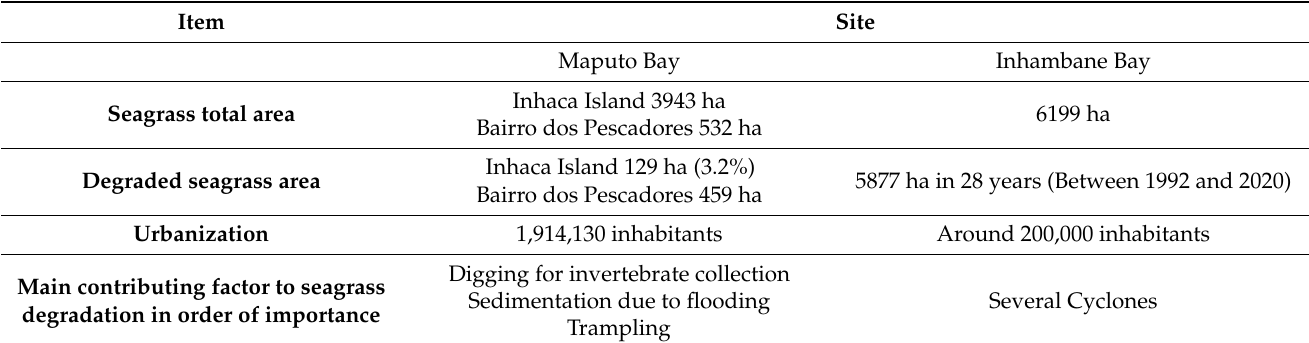
Table 1. Brief summary of seagrass status and associated risks at the sites (adapted from